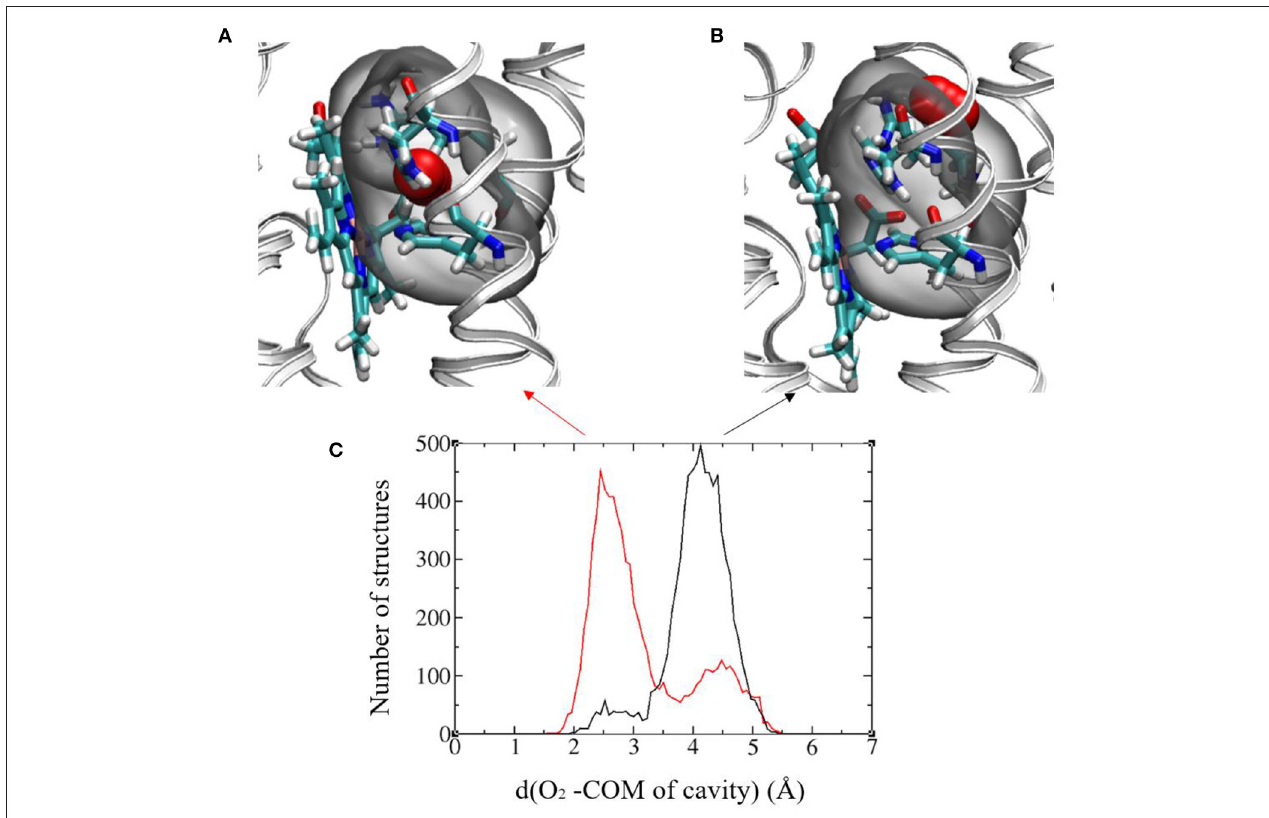
FIGURE 7 | (A) and (B) Images showing the two favored O 2 positions with respect to the binding cavity. The protein backbone is represented in gray ribbon and the cavity is highlighted in all-atom representation: Arg256, His313, and His317 and Heme2, O 2 (in red). The cavity in gray bubble. (C) Histograms of the distance between O 2 and the center of mass (COM) of the cavity in the initial (black) and final (red) redox states. Results from the 300ns-long MD